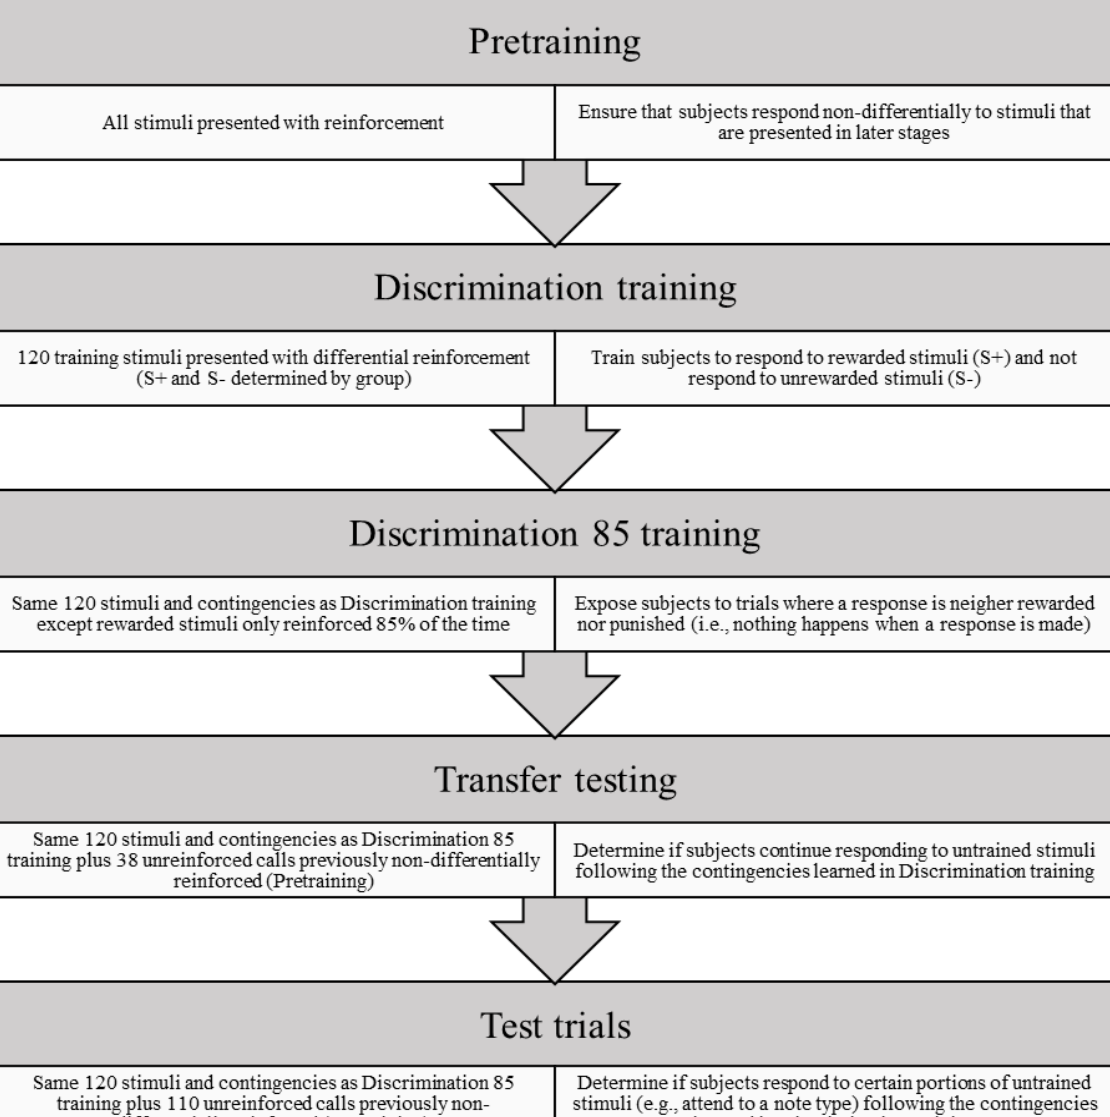
Flowchart Outlining the Stages of the Experimental